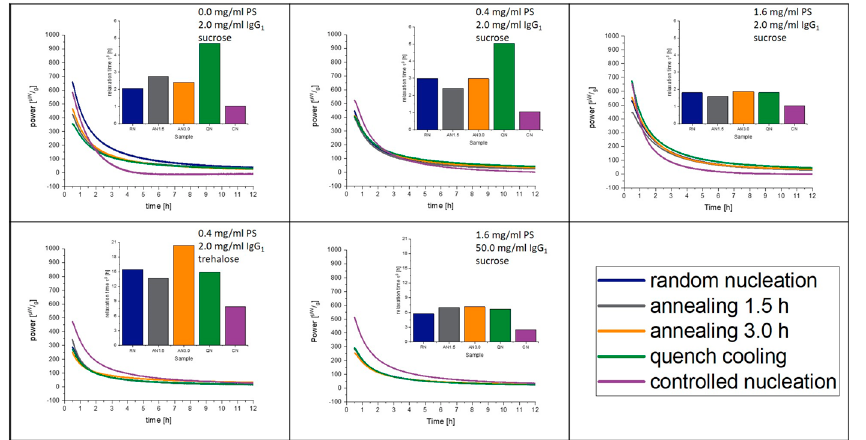
Figure 3. Relaxation curves obtained from IMC at 40 ◦ C over 12 h.